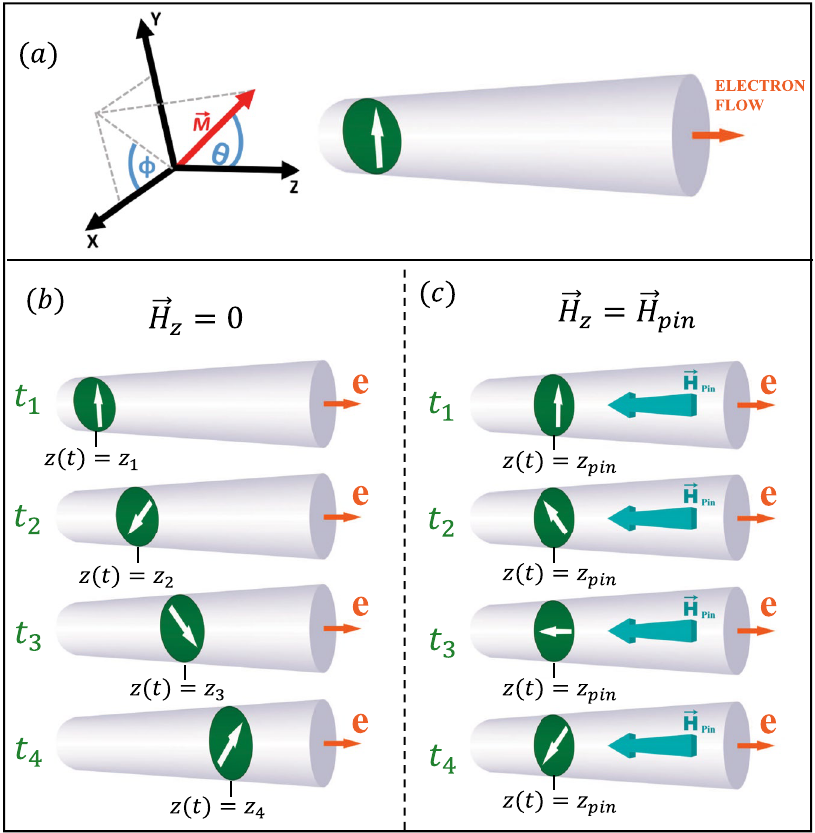
Figure 1. ( a ) The cartesian coordinate system and the spherical coordinate system used for the study of the TDW dynamics. The cross-sections indicate the position of the wall plane and the white arrows represent the orientation of the transverse magnetization. ( b ) The TDW moves linearly through the nanowire in the direction of electron flow (denoted with letter e ) with a linear velocity proportional to θ  and rotates around the axis of symmetry with velocity φ  in the absence of a magnetic field. ( c ) In the presence of a magnetic field = H H the TDW stops its linear movement, however it keeps rotating with an angular velocity φ  position z pin